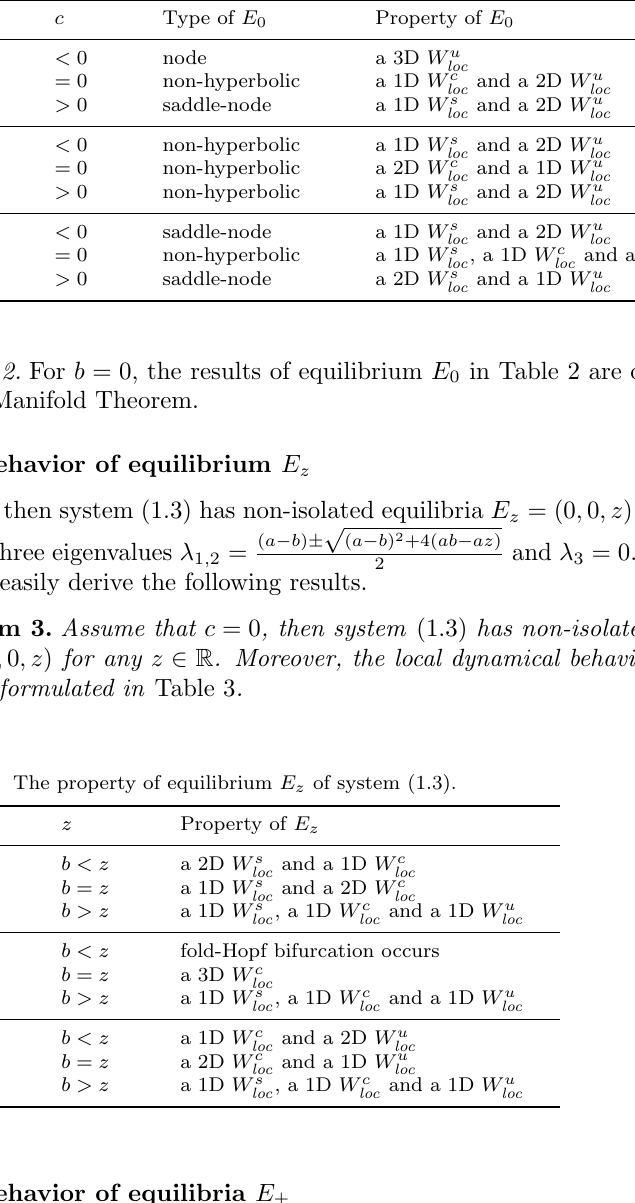
Table 2. The behaviour of equilibrium E 0 of system (1.3).